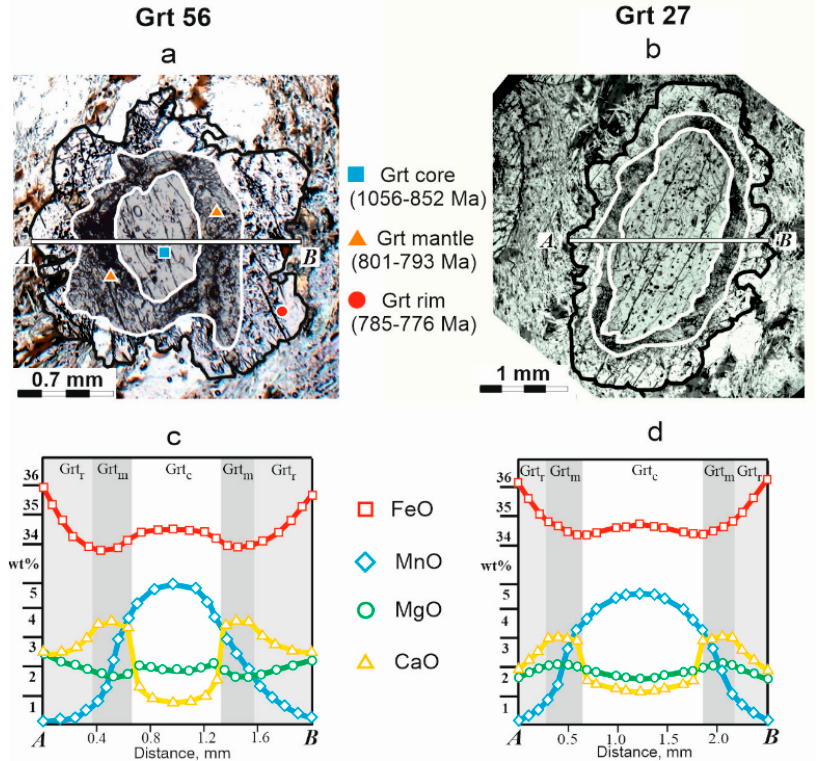
Figure 8. Photomicrographs of samples 56 ( a ) and 27 ( b ) showing texture features developed within garnets from pelitic gneisses and schists in the Garevka Complex. Compositional profile across a zoned garnet porphyroblasts (sample 56–( c ), sample 27–( d )) with three growth zones is indicated by the light line A–B. Compositionally distinct zones of garnet are indicated by white (core-Grt c ), and different shades of grey (mantle-Grt m and rim-Grt r ). The locations of dated samples (sample 56–( a )) are given with the age of the dated grain corresponding to the symbol that they are represented by.